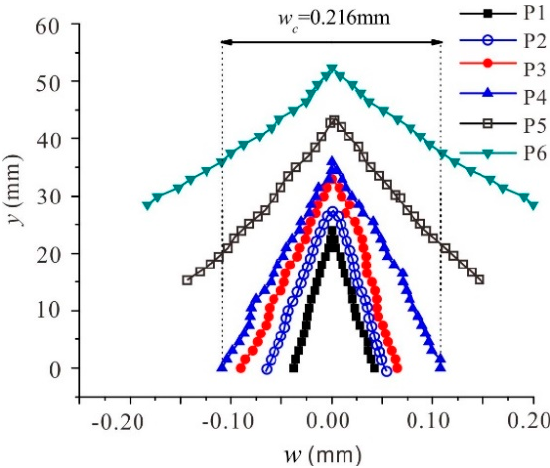
Figure 11. Crack propagation of specimen 0.3-3.